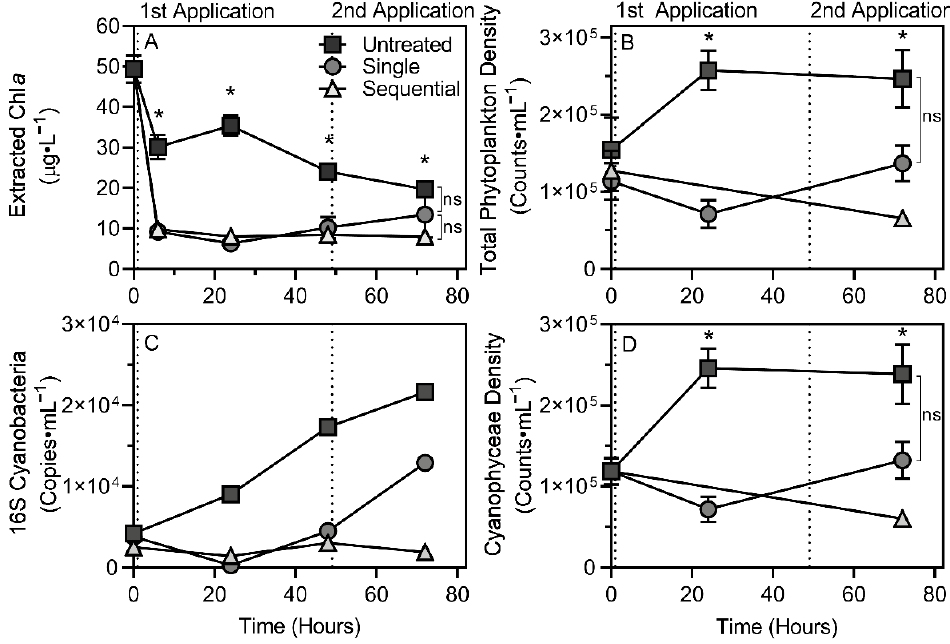
Figure 5. Bulk phytoplankton ( A , B ) and cyanobacteria ( C , D ) biomass assessments. Average extracted chlorophyll a concentrations ( A ), total phytoplankton cell densities ( B ), 16S rRNA cyanobacteria gene copy number ( C ), and cyanobacteria cell densities ( D ) for untreated (black squares), single application (dark gray circle), and sequential application (light gray triangles) mesocosms pre and post algaecide exposure. The dotted vertical line represents the first and second peroxide applications. Error bars represent +/ − SEM, n = 3–4 per treatment for A, C, D and n = 1 per condition for B. Asterisks (* p < 0.05) denote statistical significance between treated (single and/or sequential) and untreated mesocosms. Non-significant (ns) relationships can be identified by brackets. No statistical differences were noted between treatments (single and sequential).